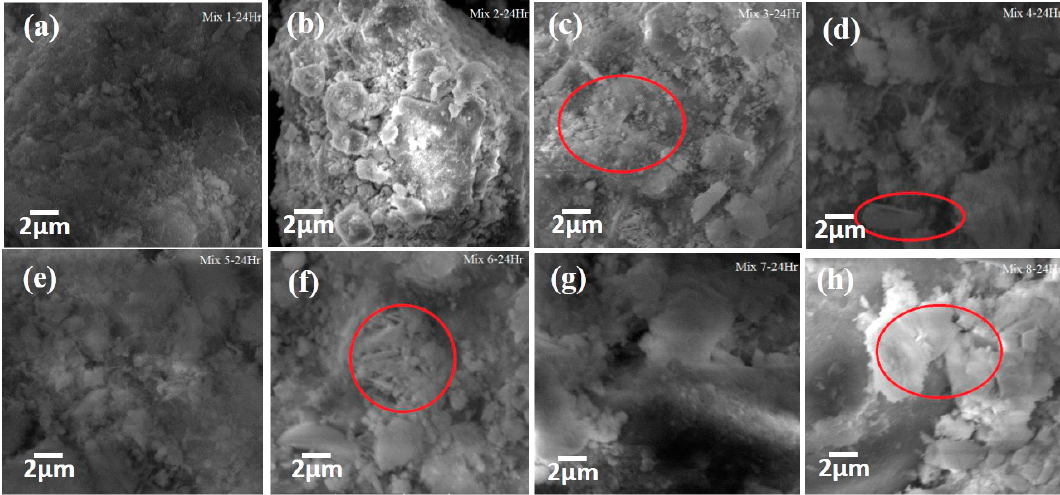
Figure 6. ( a – h ) SEM images represent the morphologies of Mixes 1 to 8 of hydration after 24 h.